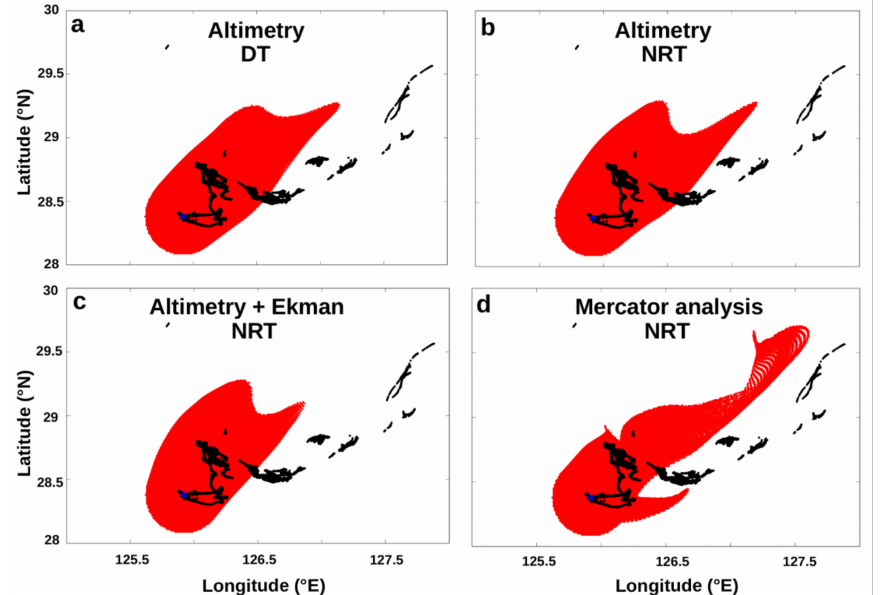
Figure 7. Six-day advection of a numerical tracer corresponding to East China Sea oil spill using different current velocity products (from satellite observations and the Mercator numerical model). The red patterns in panels ( a – d ) correspond to the output trajectory after a 6-day advection since the 14th of January 2018, initializing the tracer at the oil spill site. In panel ( a ), the red trajectory is computed from delayed-time altimetry, and in panel ( b ) from near-real-time altimetry. In panel ( c ), the red trajectory is computed from near-real-time altimetry combined with Ekman currents, and in panel ( d ) from Mercator analysis surface velocities. The real oil pathway is mapped in black based on satellite image analyses. The blue asterisk represents the location where the Sanchi tanker